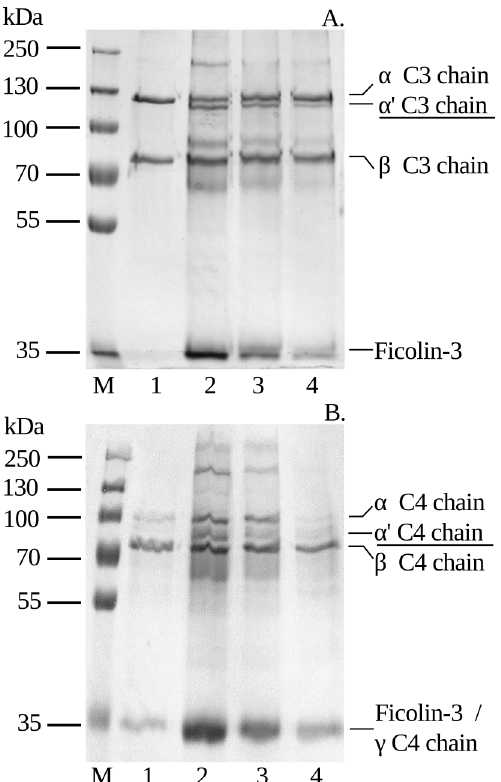
Fig 4. Cleavage of complement components C3 and C4 by plasma-derived ficolin-3/MASP complexes. C3 (A) or C4 (B) was incubated with different concentrations of ficolin-3 preparation: 5 μ g (lane 2), 2.5 μ g (lane 3), 1.25 μ g (lane 4), and control sample without ficolin-3 (lane 1). The cleavage of C3 and C4 was examined by SDS – PAGE and Coomassie Blue staining. M, molecular mass markers. Description of cleavage products is